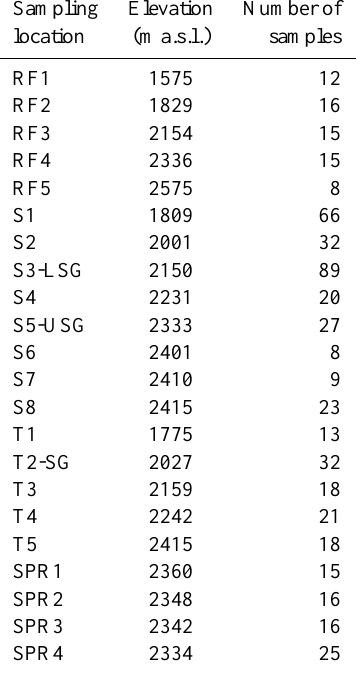
Table 2. Number of rainfall, stream and spring samples and eleva- tion of each sampling location. RF: rainfall; S: Saldur River; T: trib- utaries of the Saldur River; SPR: springs. Samples at RF1 and RF5 were not collected in 2011. Samples at T1 were collected only in 2012, and samples at T3 only in 2011. In 2013 no tributaries were sampled and samples from the main stream were collected only at four locations (S1, S3-LSG, S5-LSG, S8). Note that S7 is the con- fluence just downstream S8 and T5 but after a large flood event occurred on 4 September 2011 which modified the morphology of the upper part of the Saldur River, it was moved to